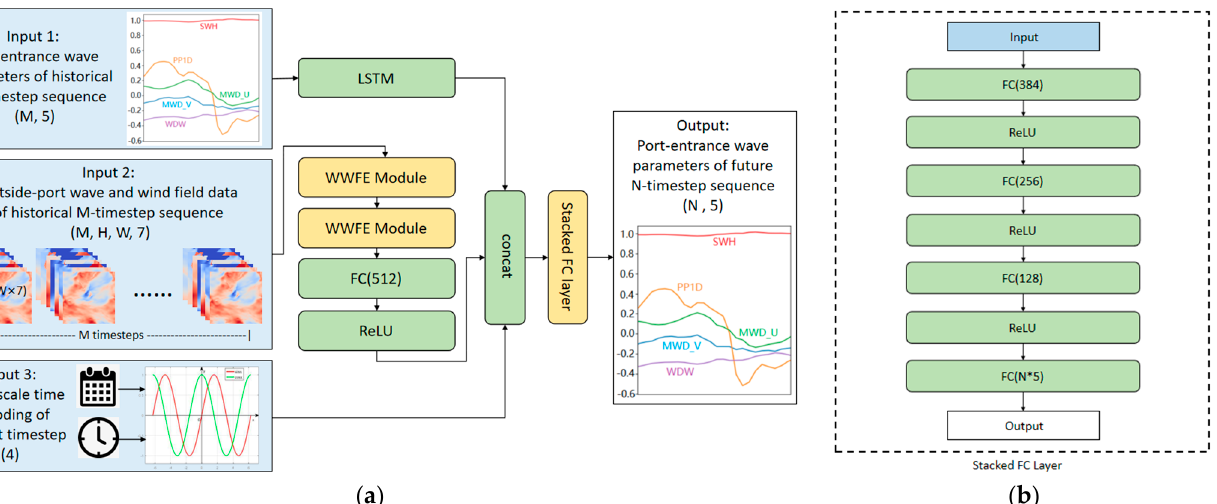
Figure 4. PWPNet structure diagram.